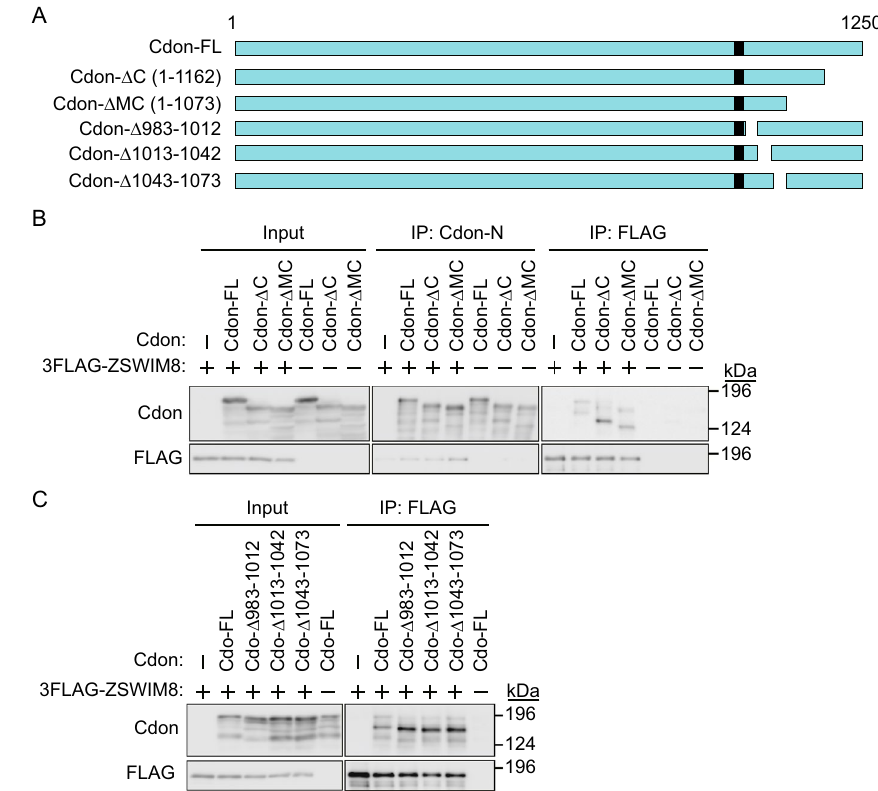
Figure 3. Interaction between ZSWIM8 and Cdon. ( A ) Schematic representation of full-length (FL) or C-terminally-deleted Cdon (ΔC; 1–1162, ΔMC; 1–1073, Δ983–1012, Δ1013–1042, and Δ1043–1073). The black box indicates the transmembrane (TM) region. ( B ) The juxtamembrane region of Cdon is recognized by ZSWIM8. HEK293T cells were transfected with empty plasmid or plasmid encoding non-tagged Cdon (FL, ΔC, or ΔMC) with or without 3 × FLAG-ZSWIM8 and cultured for 2 days. The cell lysates were immunoprecipitated with an anti-Cdon-N or FLAG antibody and immunoblotted with an anti-Cdon-N or FLAG antibody. Representative data of three independent experiments. ( C ) Deletion of the juxtamembrane region of Cdon did not affect the interaction with ZSWIM8. The experiment was performed as in ( B ). The membranes in ( B ) and ( C ) were cut prior to hybridization with antibodies. Full-length blots are presented in Supplementary Fig.